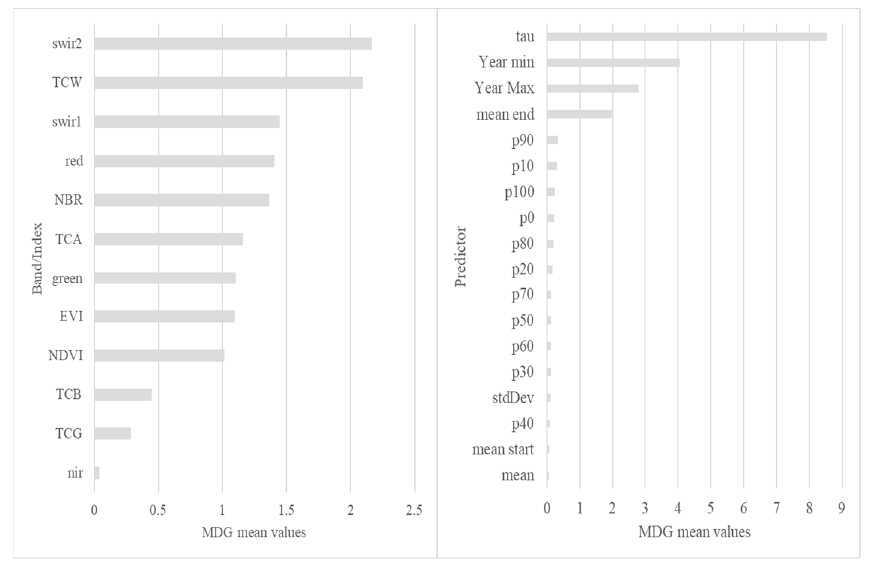
Figure 5. Importance ranking of predictors for the direct approach. In the figure, the illustrated mean values of the Mean Decrease Gini Index for each band, index, and temporal statistic.